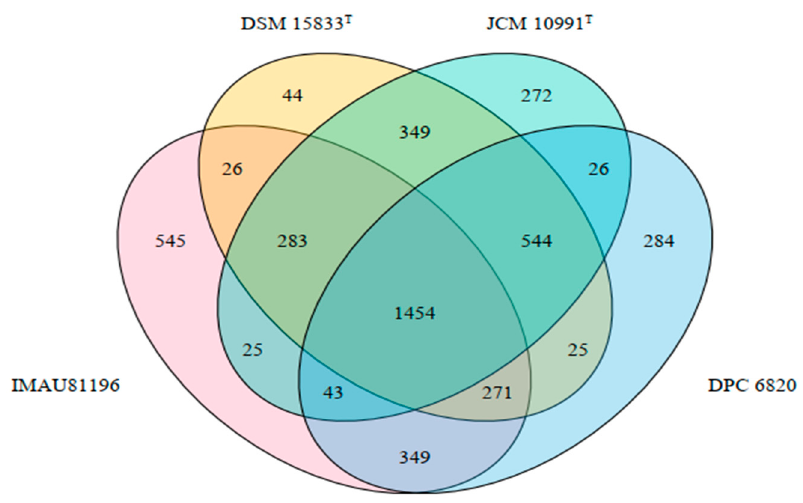
Figure 4. Venn diagram of common endemic genes of 4 strains of L. equi.